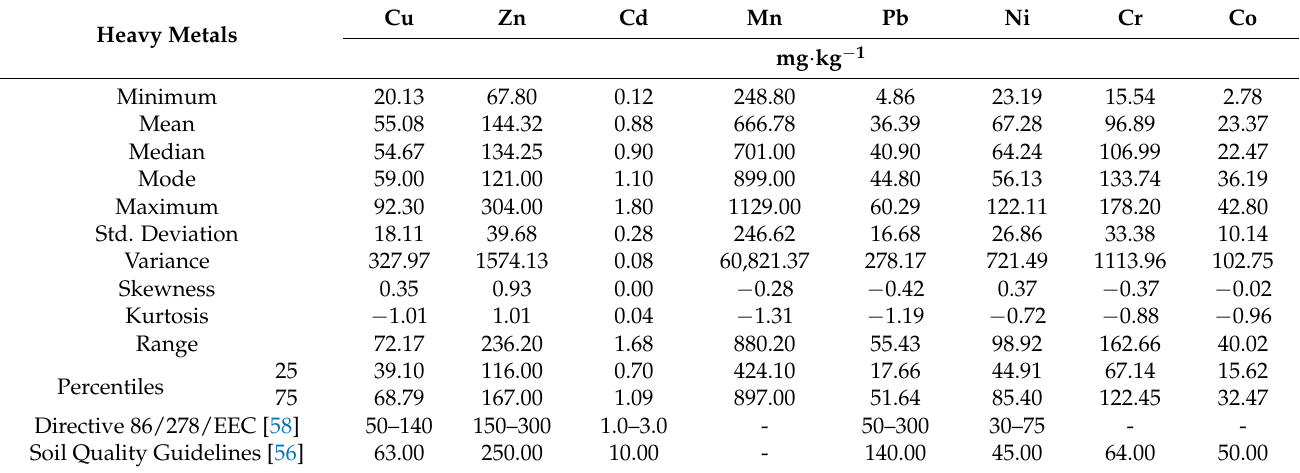
Table 2. Descriptive statistics of total concentrations of the eight HMs and comparison with